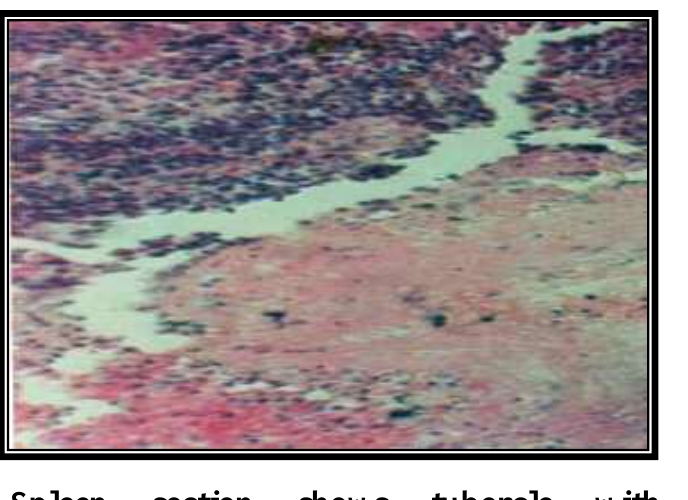
Figure (7) Spleen section shows tubercle with severe cellular